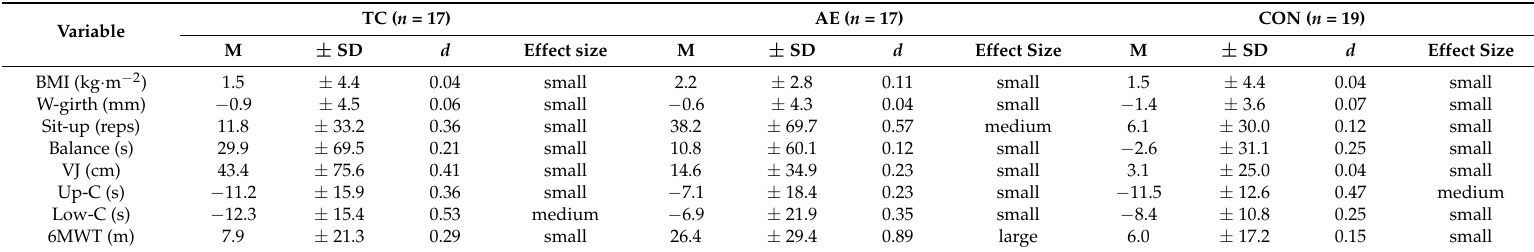
Table 3. Comparisons in the change ratio ( ∆ %) of outcomes before and after